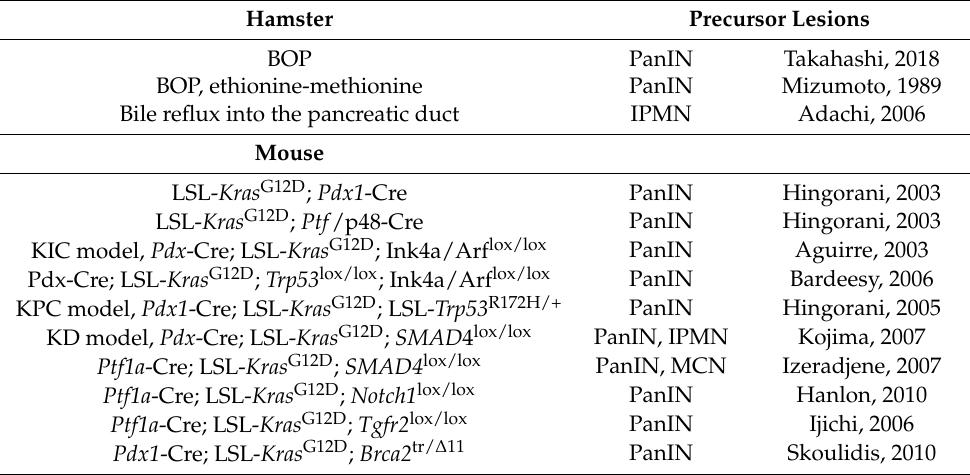
Table 2. Cancer-related pathological changes in the pancreas of various